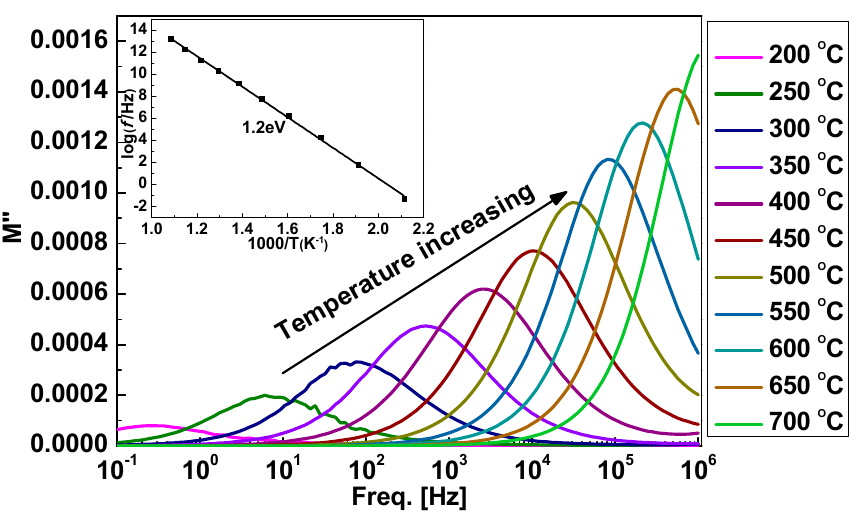
Figure 5. The frequency dependence of the electric modulus ( M ”) for Fe-substituted PMN-32PT ferroelectric crystal at different temperature, and relaxor activation energy ( E relax ) (inset).